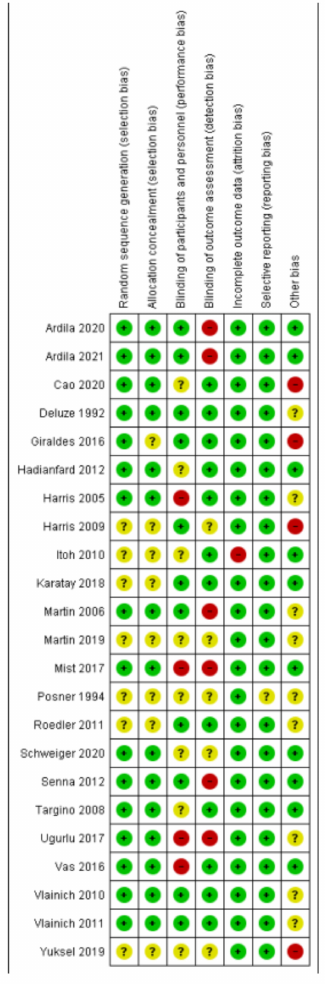
Figure 2. Risk of bias